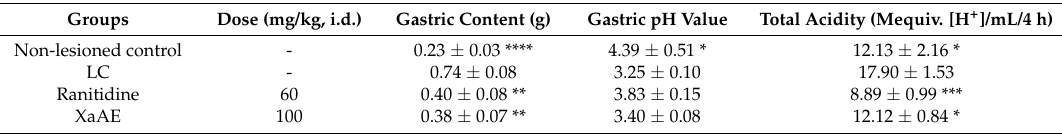
Table 3. Effect of X. americana (XaAE) aqueous extract on gastric secretion parameters in Wistar rats subjected to pylorus